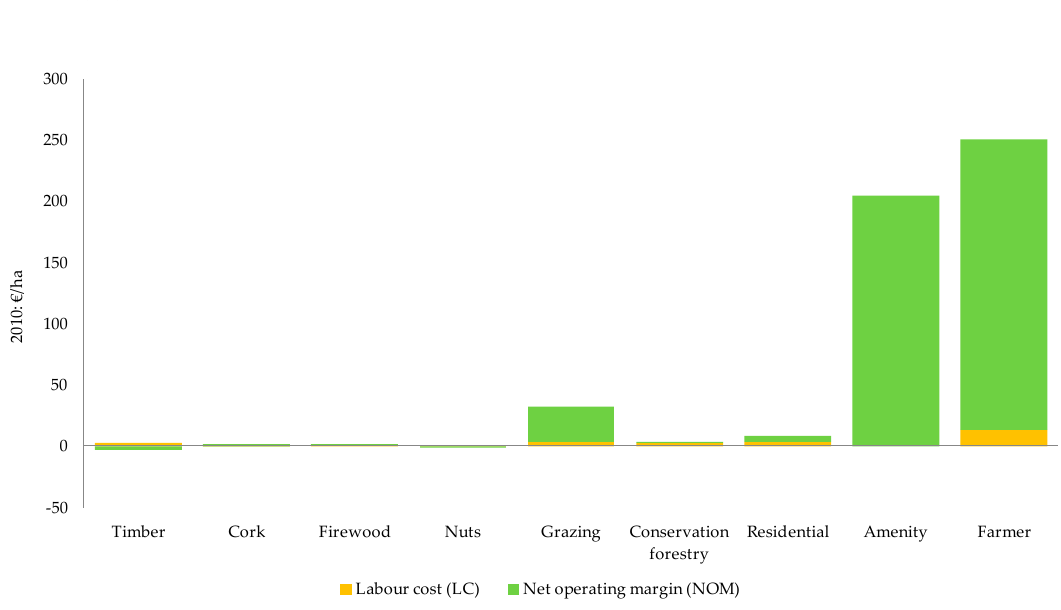
Figure 2. Agroforestry Accounting System farmer net value added at social prices of holm oak open woodlands in Andalusia (2010: €/ha).